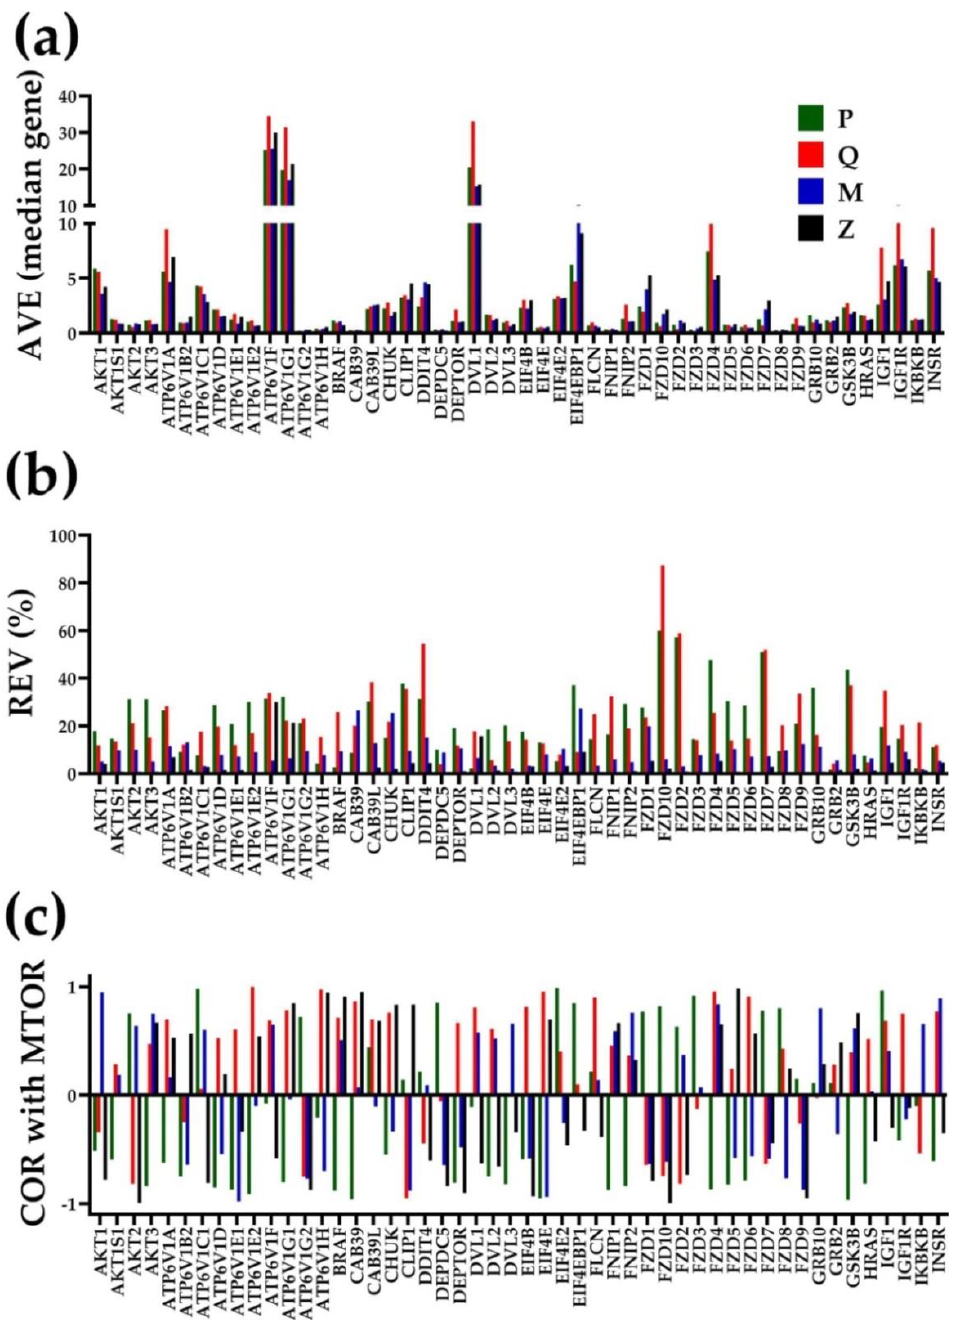
Figure 1. Independent transcriptomic characteristics of the first 50 alphabetically ordered genes of the mTOR signaling pathway in the three cancer nodules (“P”, “Q” and “M”) and the surrounding normal prostate tissue (“Z”). ( a ) Average expression levels (AVE) in expressions of the median gene. ( b ) Relative expression variability (REV). ( c ) Expression correlation (COR) with MTOR.